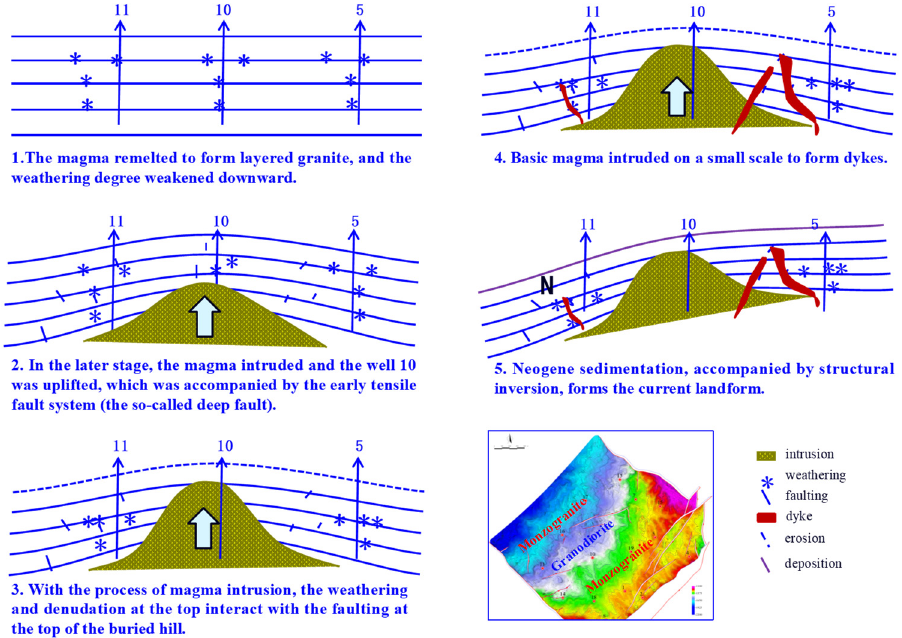
Figure 6. Schematic diagram of formation and evolution mode of the buried-hill in the PL oilfield.